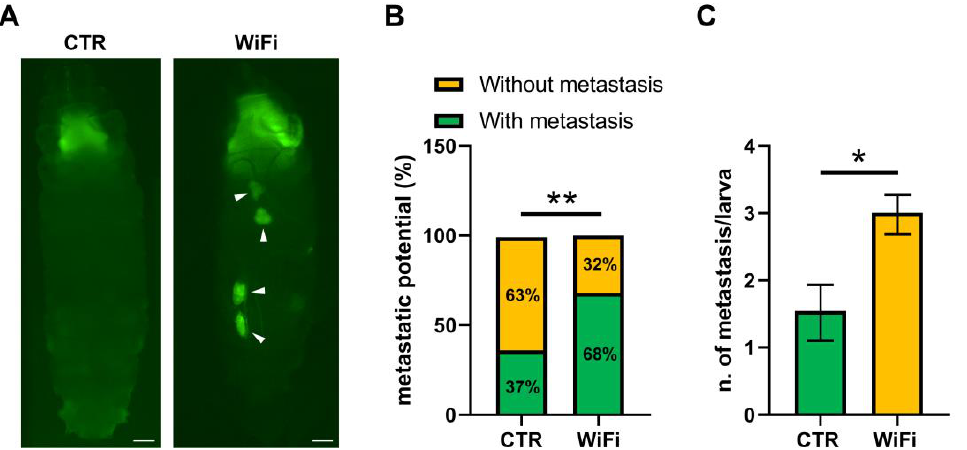
Figure 9 . ( A ) WiFi exposure promotes overgrowth and metastasis of GFP-positive Ras V12 cells. Arrowheads indicate migrating tumors. Scale bars indicate 200 µ m. ( B , C ) Analysis of metastatic behavior in control and WiFi exposed larvae. About 100 larvae were analyzed from four independent biological replicates. Statistical significance was determined using Fisher’s exact test ( B ) and the Unpaired t test ( C ) (* p ≤ 0.05; ** p <